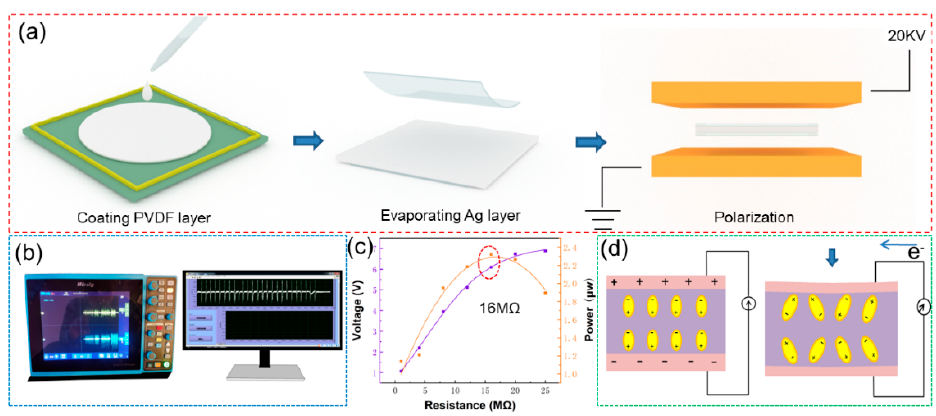
Figure 2. ( a ) The sensor fabrication; ( b ) measuring system; ( c ) output voltage and output power of the sensor; ( d ) working mechanism. the sensor; ( d ) working